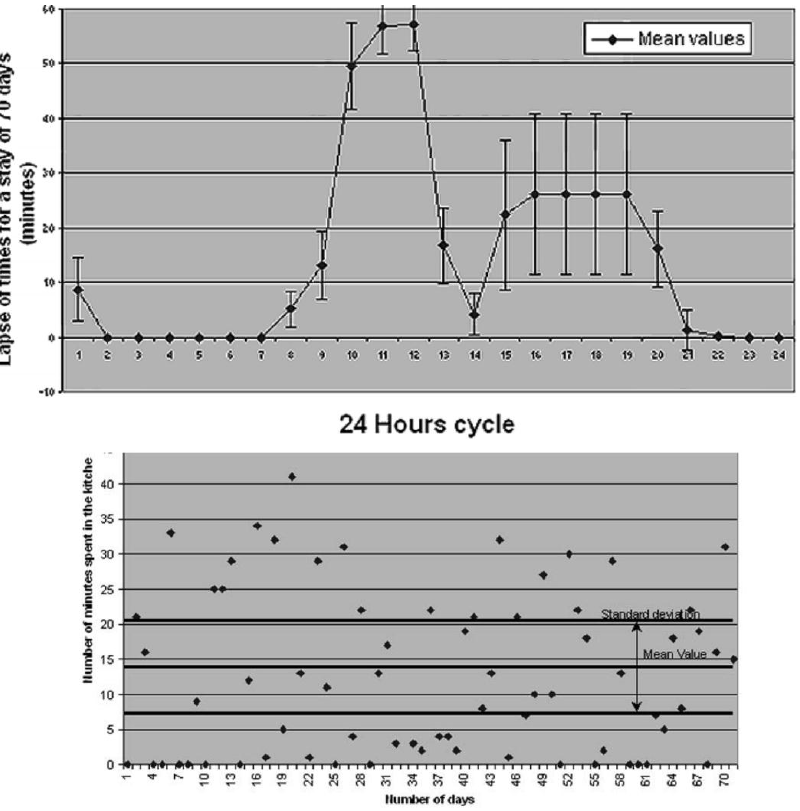
Figure 7. Top: actigram showing the mean and standard deviation of the successive lapses of time spent in a room during a nychthemeron (24 successive hours), calculated after 3 weeks within a period of 70 days of observation. Bottom: number of minutes spent in each room in which the tasks corresponding to one action done during the nychthemeron are performed (the example given concerns the kitchen).